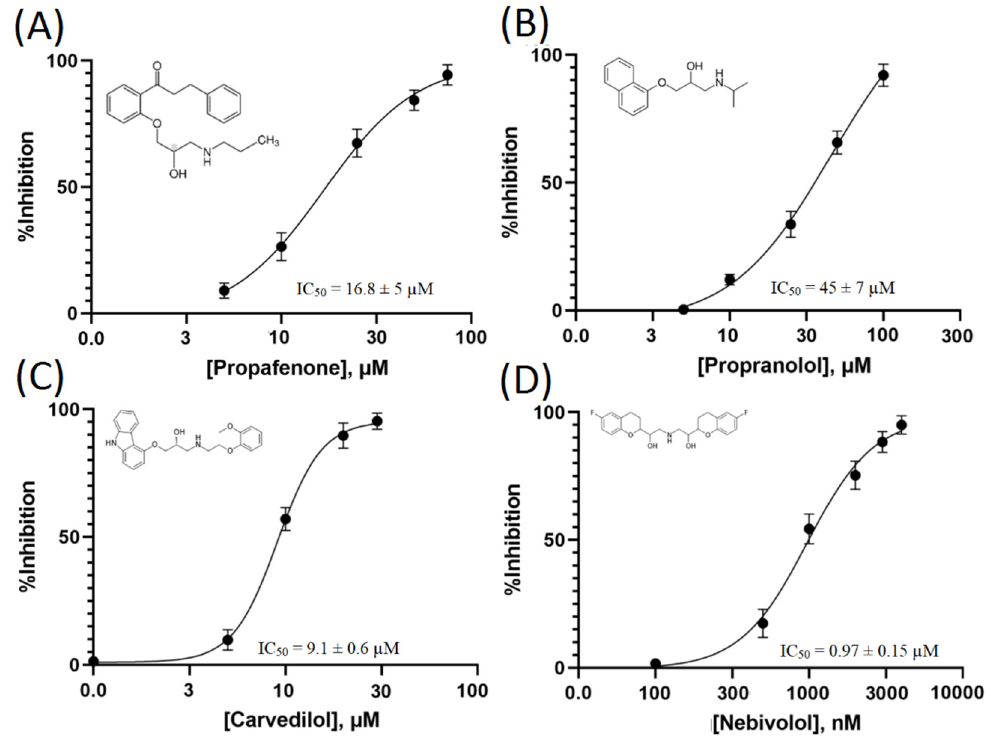
Figure 2. Dose response curves of the selected β -blockers capable of inhibiting TRPM8 channels. Data were obtained using the IonFlux16 device. ( A ) Propafenone, ( B ) Propranolol, ( C ) Carvedilol, ( D ) Nebivolol. All IC 50 were calculated by fitting the four-parameter Hill equation; all data are shown as the mean ± SD ( n ≥ 6).